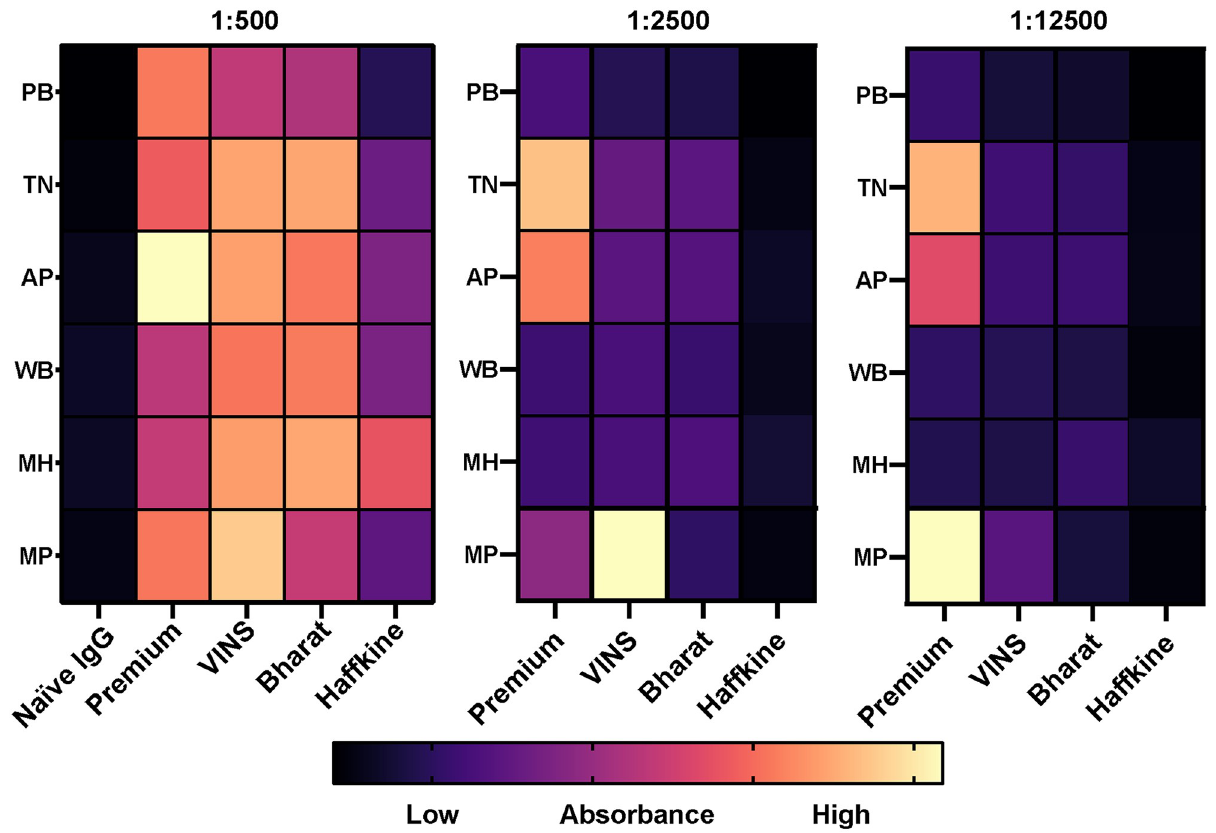
Fig 5. Immunological cross-reactivity of commercial Indian antivenoms against the pan-Indian populations of D . russelii venoms. Heatmaps, shown here, quantify the binding of commercial Indian antivenoms to the venoms of pan-Indian populations of D . russelii . Multiple dilutions of antivenoms (1:500, 1:2500 and 1:12500) were tested in indirect ELISA experiments. Non-specific binding of naive horse IgGs (1:4 dilution) to Daboia venoms is also shown in the first plate for reference. A gradient colour scale has been shown indicating the degree of binding from low (black) to high (cream). PB: Punjab; TN: Tamil Nadu; AP: Andhra Pradesh; WB: West Bengal; and MH: Maharashtra; MP: Madhya Pradesh.